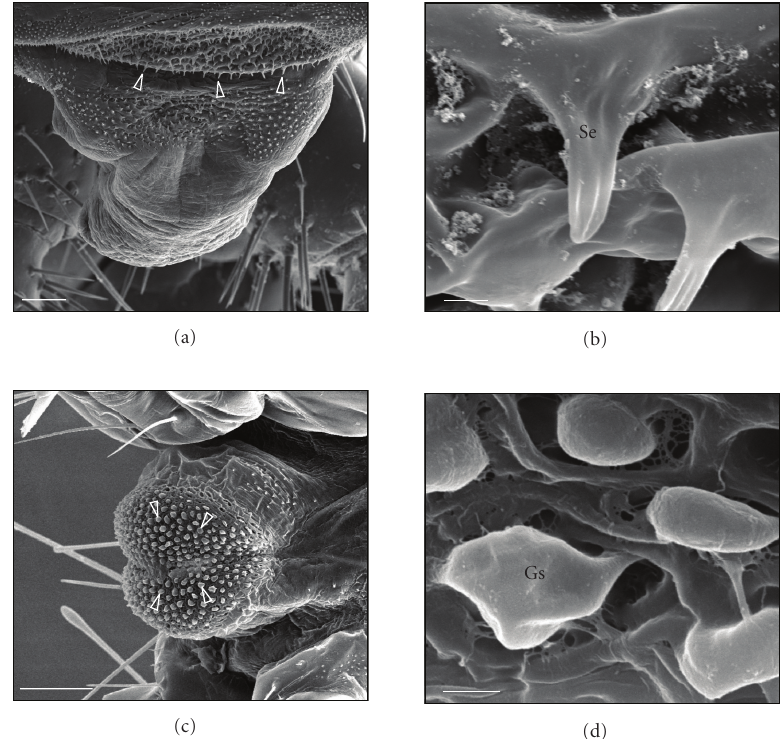
Figure 4: Impair prosternal gland of Heliconius erato phyllis under scanning electron microscopy. (a) Detail of the transverse opening slit in a fifth instar, anterior view; (b) sensilla on the opening margin (indicated by open arrowheads in (a)); (c) detail of a protruded gland in a first instar, latero-ventral view; (d) cisterns in detail, showing exudation (indicated by arrowheads in (c)). Gs: glandular secretion; Se: sensillum. Scale bars: 100, 5, 100, 2 µ m,